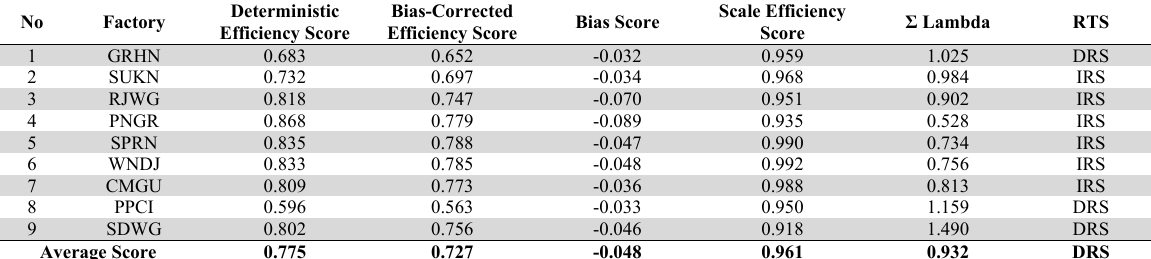
Efficiency Score & RTS Type of Each Pine Chemical Factory